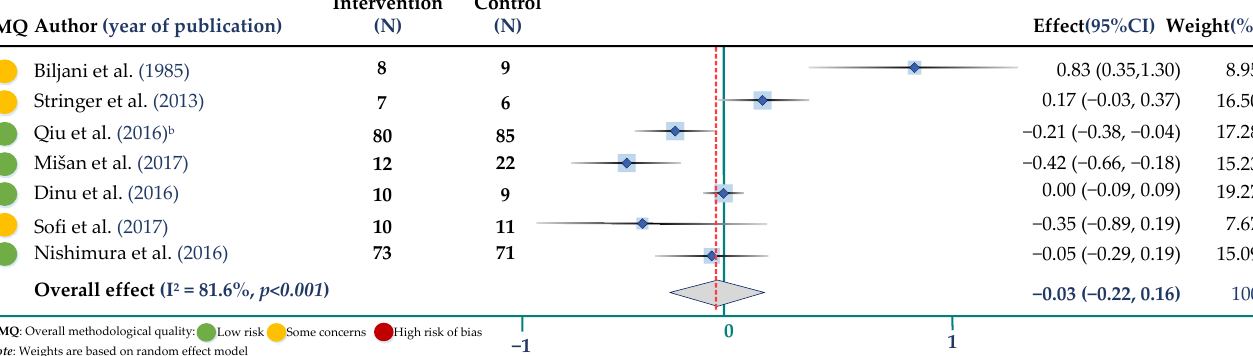
Figure 5. Meta-analysis of buckwheat supplementation and LDL cholesterol. b indicates the Qiu study according to Table 2 [17,18,22,25,28,31,32].